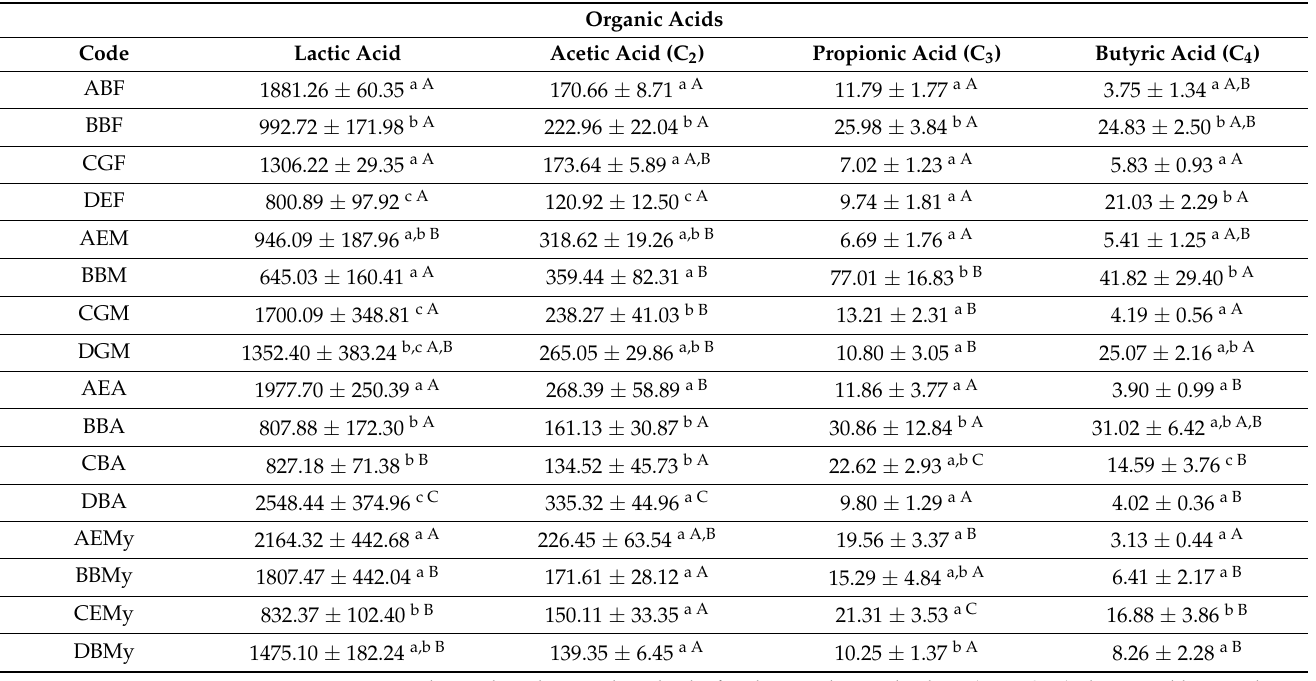
Table 4. Organic acids (mean ± standard deviation; mg/100 g) in samples from producers A, B, C and D, during four consecutive months of production. Organic